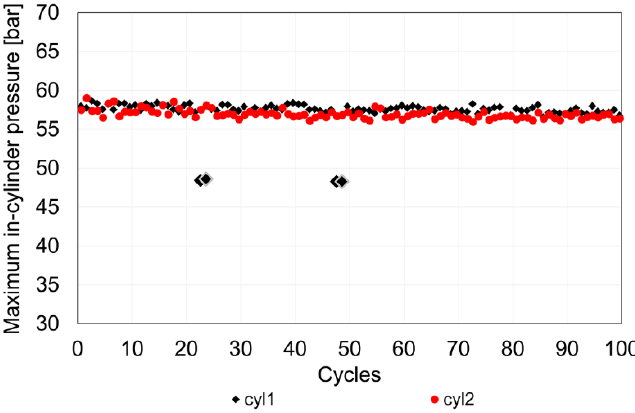
Figure 23. Maximum in-cylinder pressure for 100 consecutive cycles at 1000 rpm and low load with a misfiring imposed for two consecutive cycle in the cylinder 1. Comparison between cylinder 1 and 2.